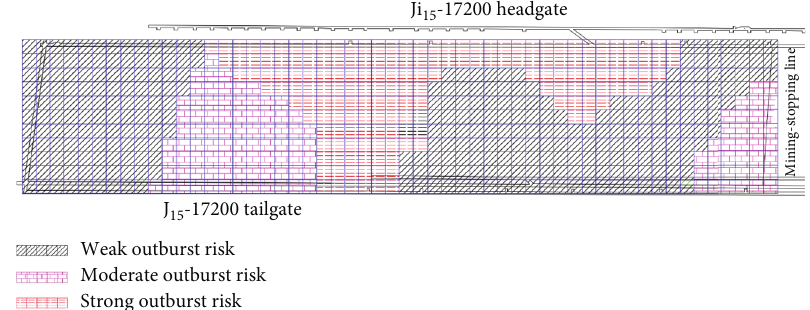
Figure 3: The classi fi cation prediction result of coal and gas outburst risk of the Ji